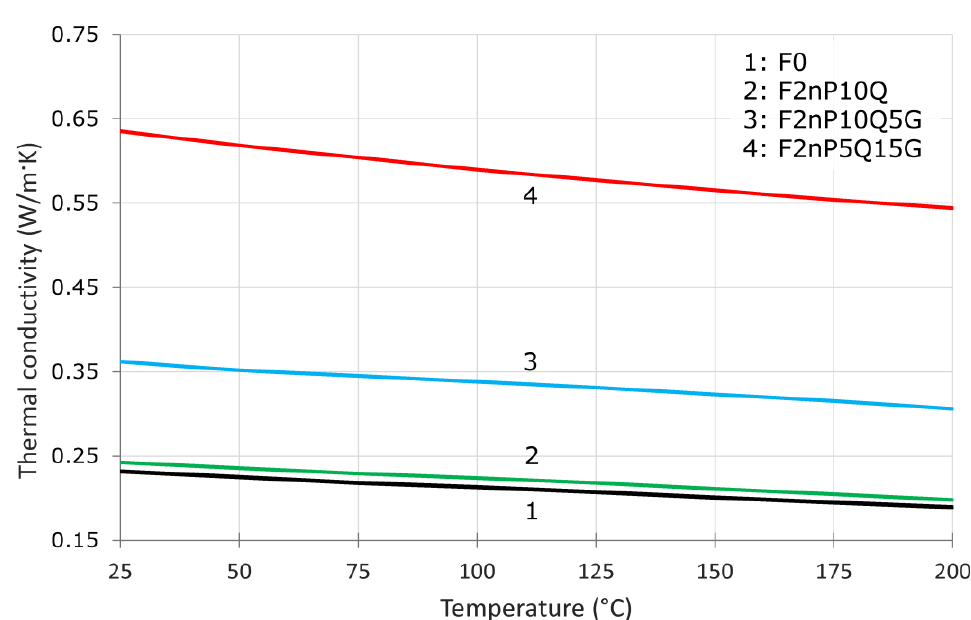
Figure 4. Temperature dependences of thermal conductivity for unfilled FEP and FEP-based com- posites.